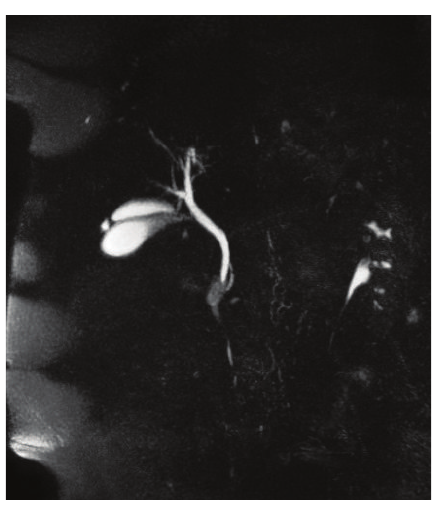
Figure 2: MRCP image showing the single cystic duct, draining to a common hepatic duct.